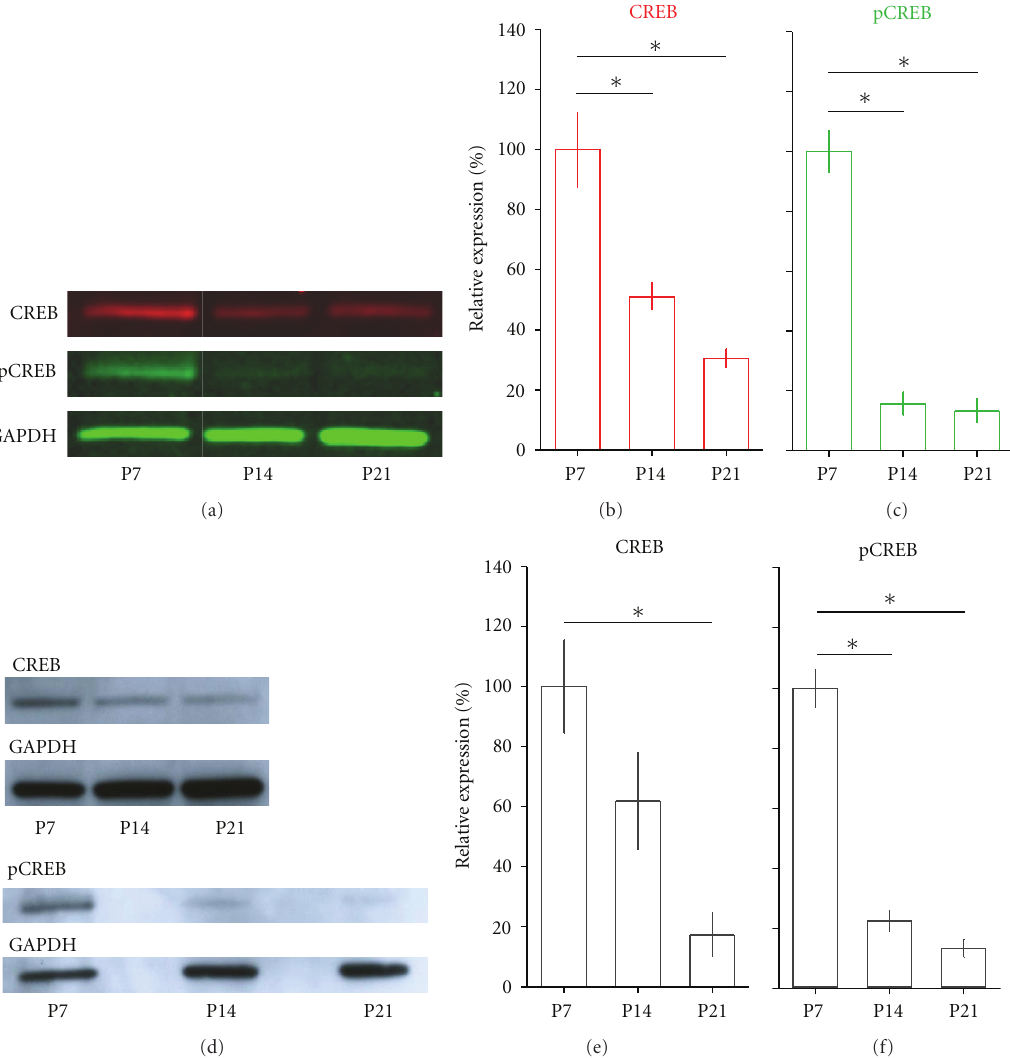
Figure 2: CREB and pCREB levels during early postnatal development in mouse dLGN. (a) Representative western blots of CREB and pCREB protein levels measured in dLGN at P7, P14, and P21 using infrared imaging detection. Red represents CREB levels and green pCREB and GAPDH levels. Both CREB and pCREB levels decreased with age. ((b) and (c)) Quantification of immunoblots for CREB (c) and pCREB (d) using infrared imaging. The bars depict the relative averaged optical densities measured at P7, P14, and P21. CREB and pCREB levels were significantly higher at P7 than at P14 and P21 (LSD post-hoc tests, ∗ P < 0 . 01). (d) Representative western blots of CREB and pCREB protein levels measured in dLGN at the same postnatal ages as in (a) using chemiluminescence detection. ((e) and (f)) Quantification of immunoblots for CREB (e) and pCREB (f) using chemiluminescence. Similar to infrared imaging, CREB and pCREB levels significantly decreased with age ((e) LSD post-hoc test and (f) Tamhane’s post-hoc test; ∗ P < 0 . 01). Error bars represent ± SEM. Infrared imaging detection, n = 5 blots; chemiluminescence, n = 3-4 blots; n = 6–8 dLGNs in each age group per blot for both